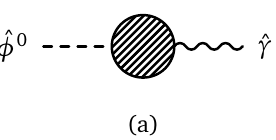
Figure 2: Standard Model diagrams contributing to Higgs boson decays to two pho- tons which vanish identically. These diagrams, if nonzero, would contribute to one- particle reducible diagrams where the ˆ φ 0 or ˆ Z are contracted with a ˆ H ˆ φ 0 ˆ Z or ˆ H ˆ Z ˆ Z